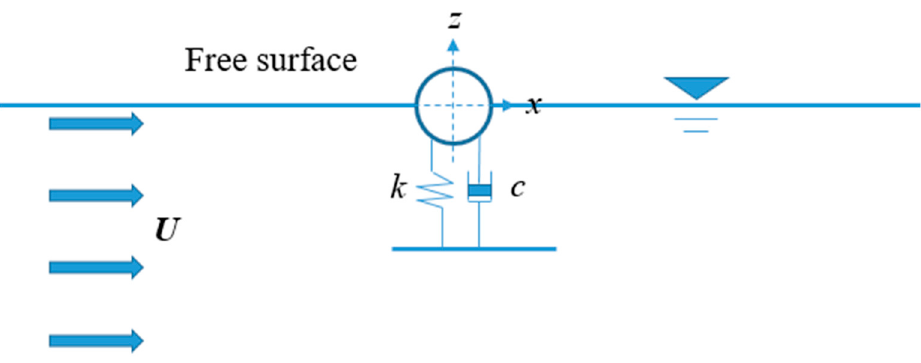
Figure 8. Spring damping system.